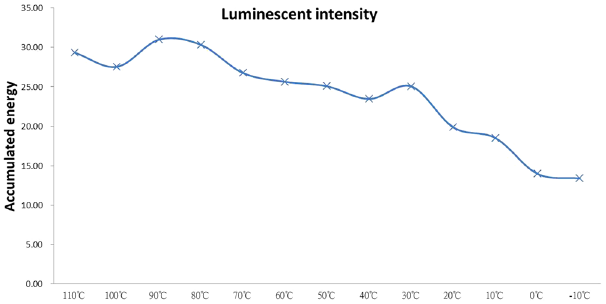
Figure 3. The TL-time-integrated intensity of Fig. 1. There are two peaks visible in the curve.